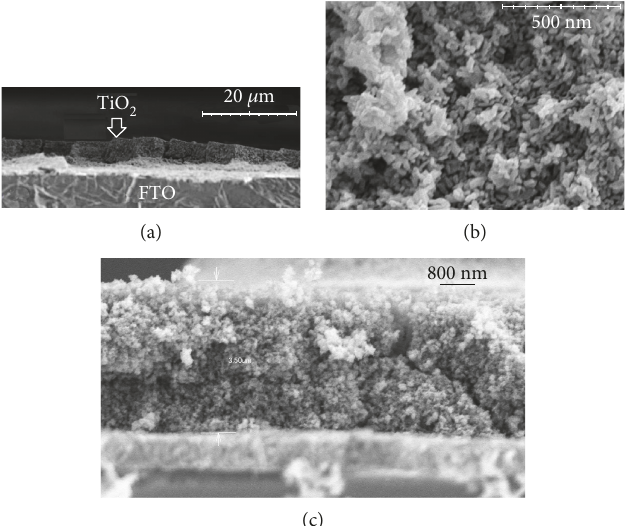
Figure 2: SEM images of the porous layer of deposited BR-TiO fi lm. (b) Top side image. (c) A SEM image of 3.5 μ m thick TiO image of 5 μ m thick TiO 2